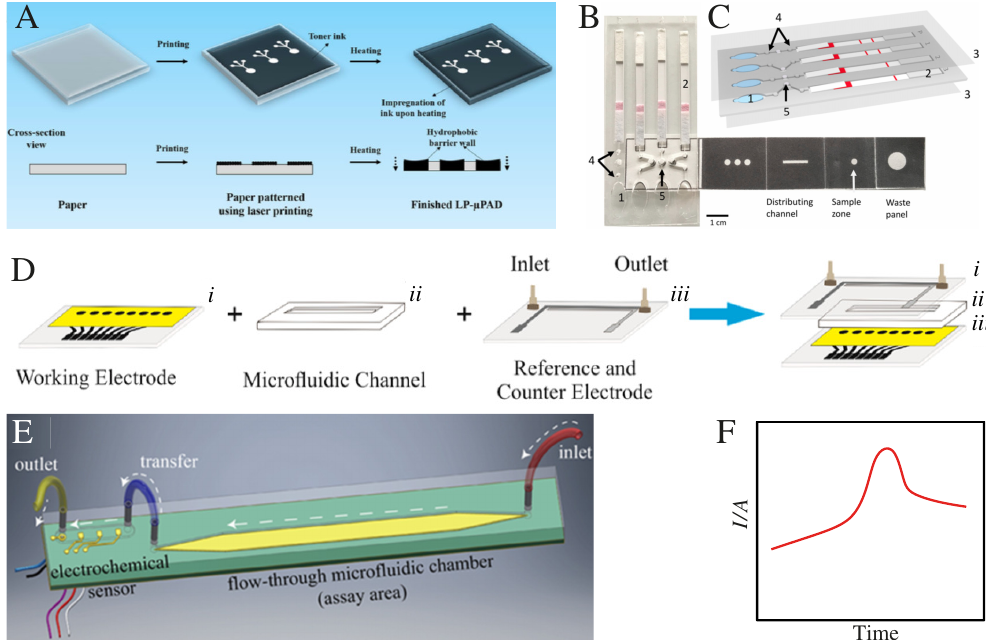
Figure 1. ( A ) Pictorial representation of a simple two-step procedure to fabricate LP- µ PADs, consisting of printing and heating of the printed substrate. ( B ) An assembled paper-plastic microfluidic device for amplification and detection of malaria in blood. A paper origami device for DNA extraction and processing fabricated by hot wax printing method is attached. ( C ) Key features of the plastic microfluidic device: (1) manually pressed fluid chamber for fluid flow; (2) DNA detection strip; (3) safe handling (without evaporation) using acetate film covers; (4) filter paper-based valves for precise control of the LAMP reaction; and (5) filter paper for the LAMP reaction. ( D ) Schematics of the fabrication steps: ( i ) screen-printed carbon-based working electrodes; ( ii ) polystyrene card with double-sided adhesive with the microfluidic channel; and ( iii ) reference and counter electrodes with the inlet and outlet. ( E ) Illustration of the assay area and electrical connections of a unit cell of the fluidic arrangement in the printed circuit board electrochemical sensor. ( F ) Illustration of the amperometric detection mechanism for biosensors in ( D , E ). ( A ) was adapted with permission from Ref. [43]. Copyright 2019 Springer Nature. ( B , C ) are used with permission from Ref. [23].